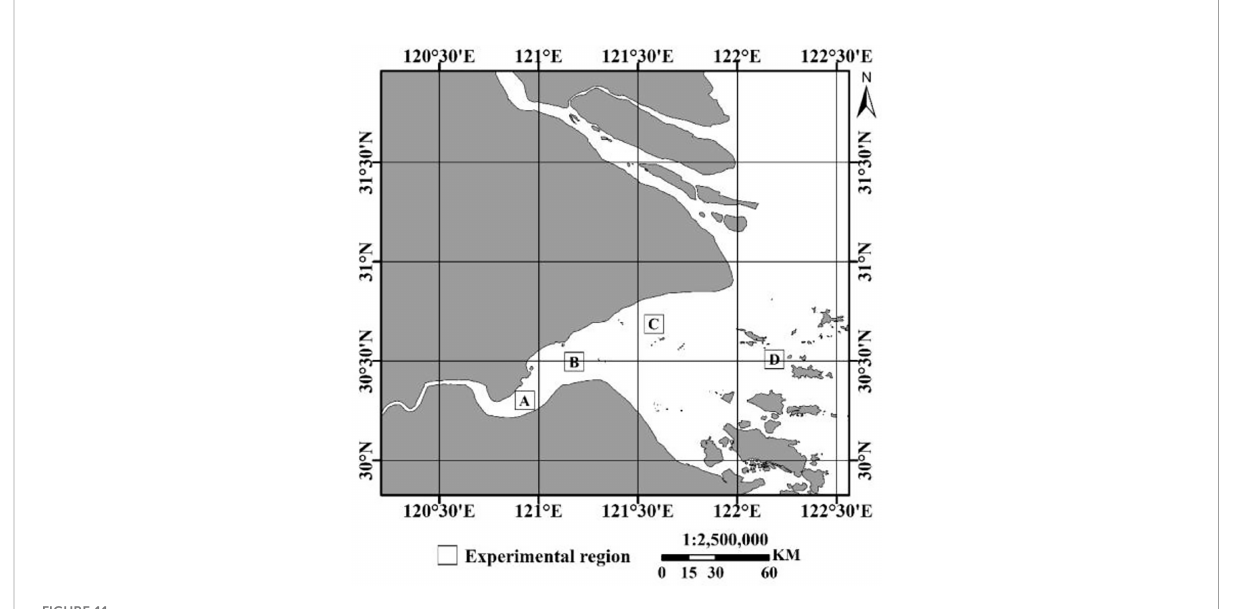
FIGURE 11 Experimental region division of suspended sediment average concentration statistics.